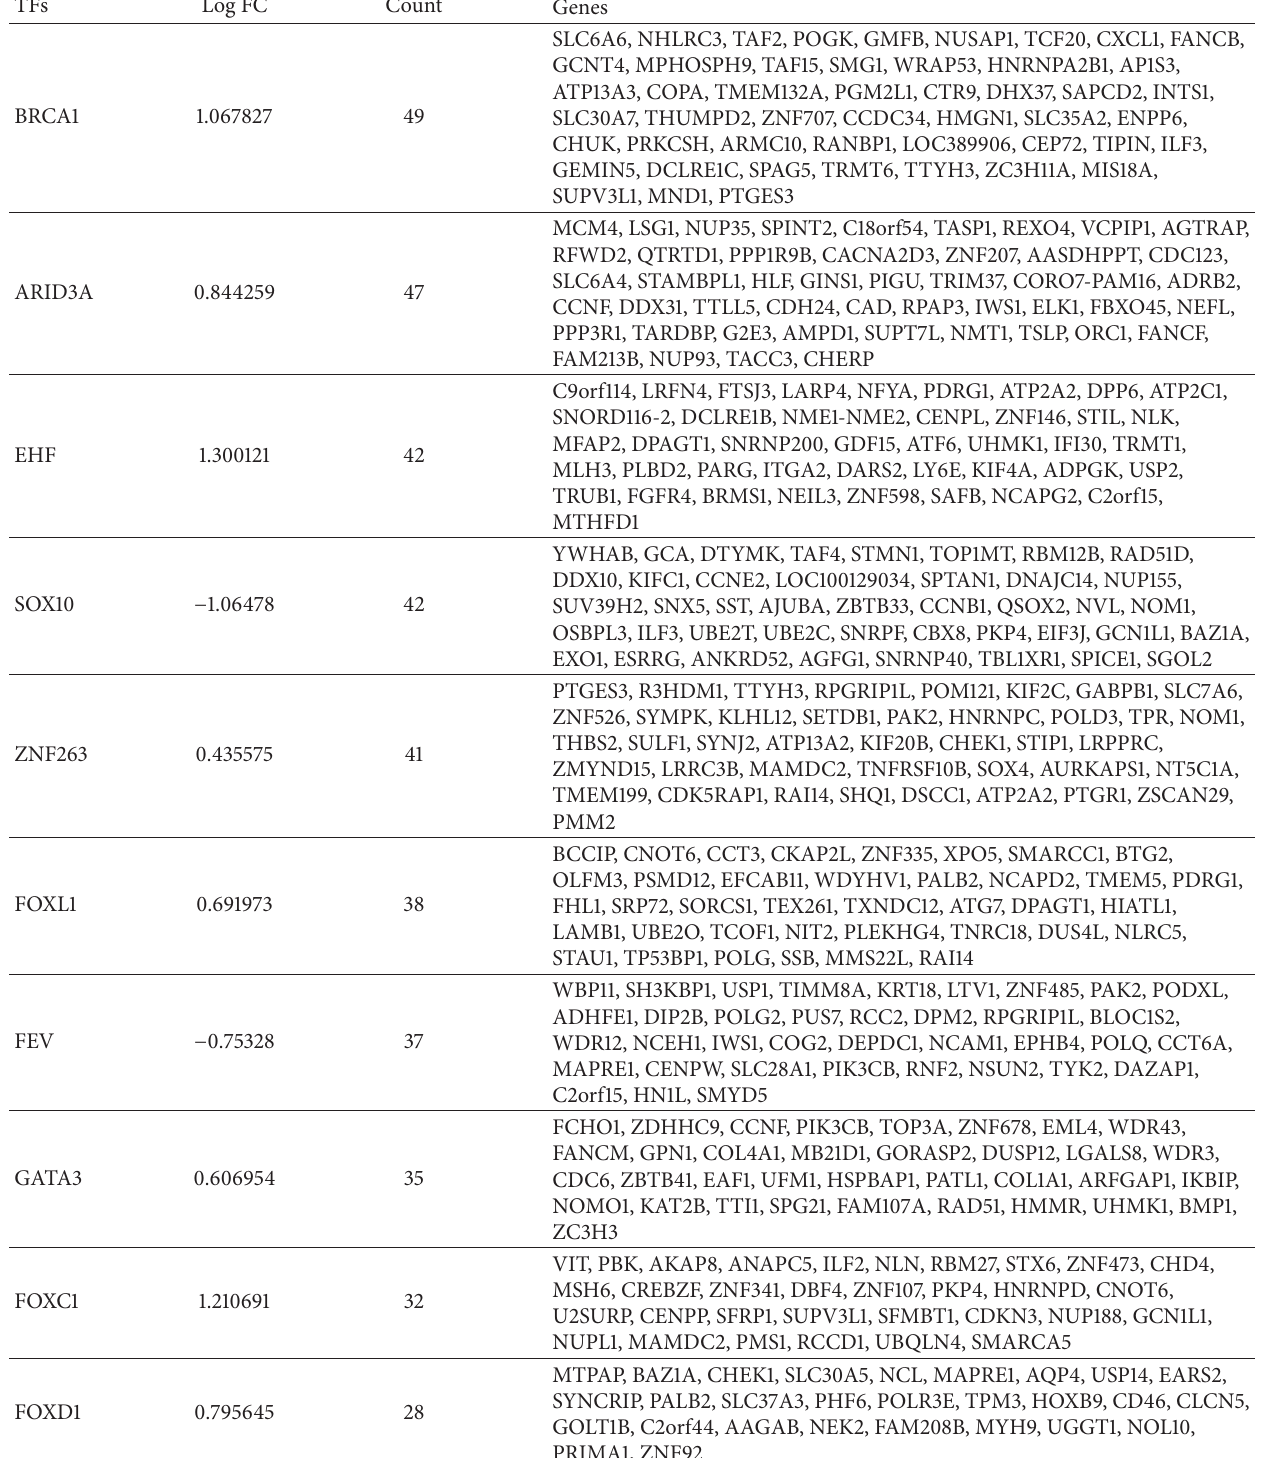
Table 5: Top ten TFs interacting with the most